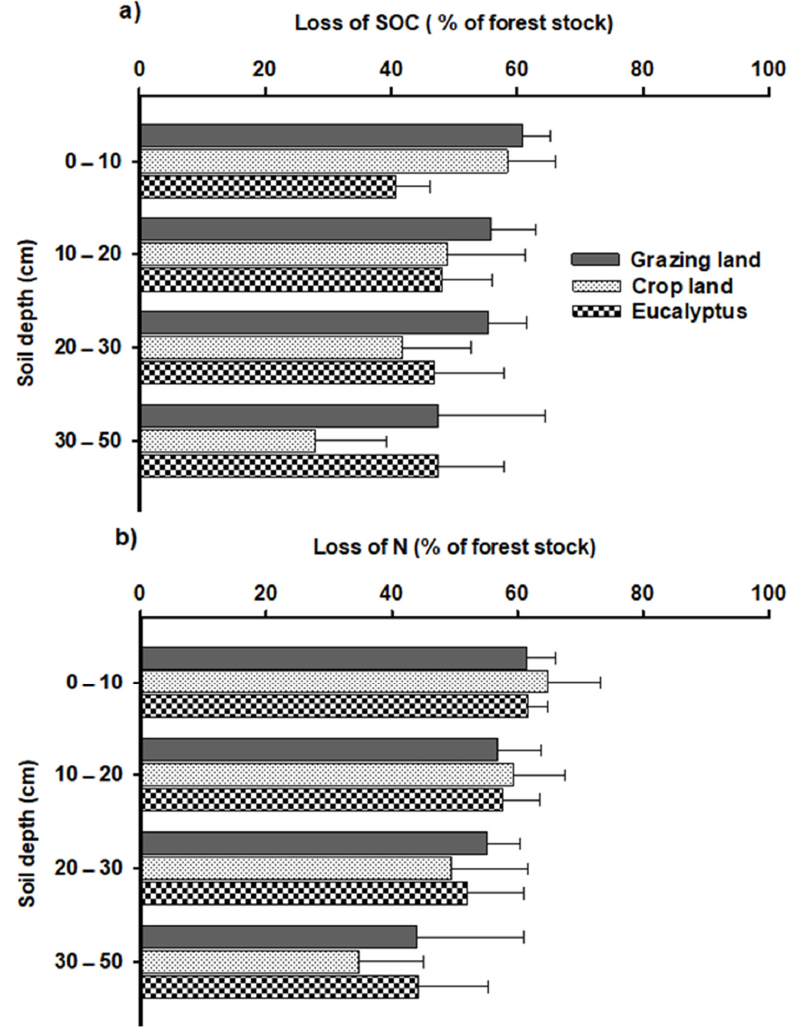
Figure 2. Loss of C and N after conversion of natural forest to grazing and crop lands and eucalyptus plantation. ( a ) Percent loss of SOC stocks in compare with original natural forest, ( b ) Percent loss of soil N stock in compare with natural forest. Losses were estimated four vertical soil layers from 0–50 cm soil depth. Mean % of forest stocks (± SE).